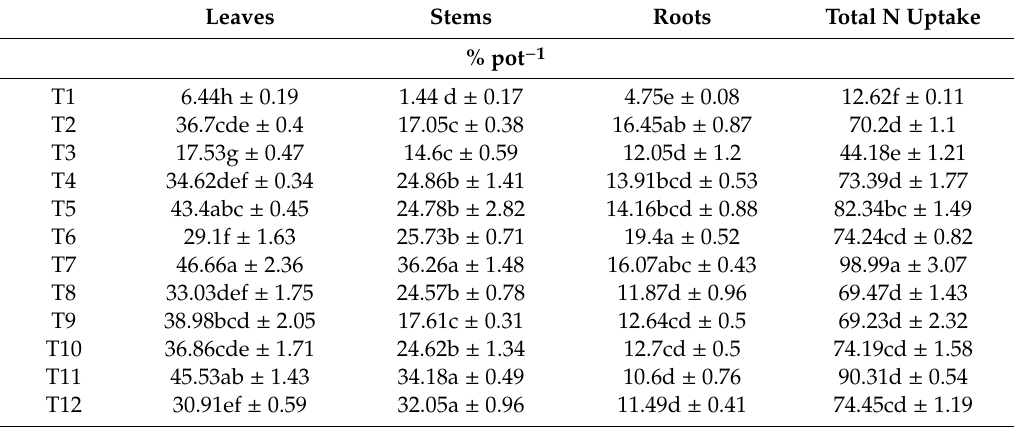
Table 5. E ff ects of co-applied biochar on nitrogen uptake of leaves, stems, and roots uptake of maize at tasseling stage. Leaves Stems